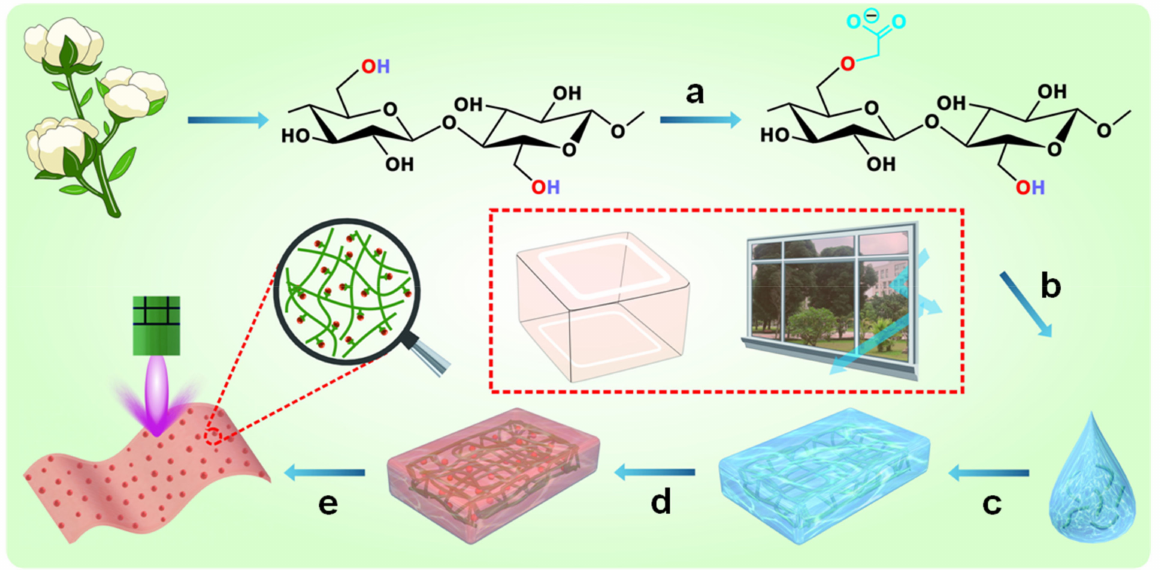
Scheme 1. Schematic illustration of concept of fabricating M(Fe)CCFs based on cellulose and nano- MIL-88A(Fe) for UV-blocking. (a) Carboxymethylation of cellulose; (b) Dissolution of cellulose; (c) Formation of carboxymethylated cellulose hydrogel; (d) Formation of composite hydrogel by in situ synthesis of nano-MIL-88A(Fe); (e) Formation of clear M(Fe)CCFs by